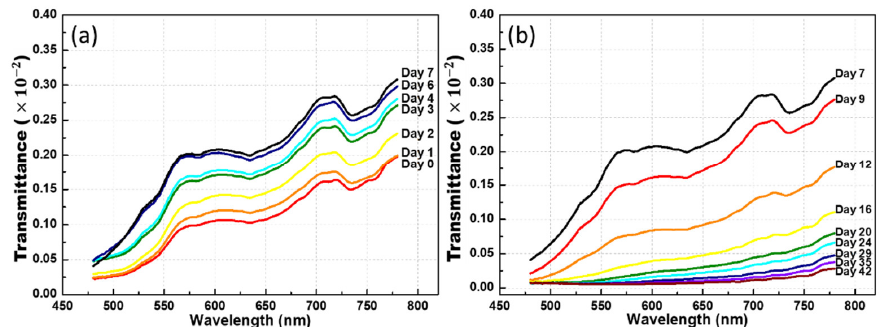
Figure 5. Average transmittance over the 70 duck eggs during the pickling process. ( a ) The average transmittance approximately doubled in the first week, and the standard deviation (SD) was 0.34. ( b ) From days 7 to 42, the transmittance gradually decreased.